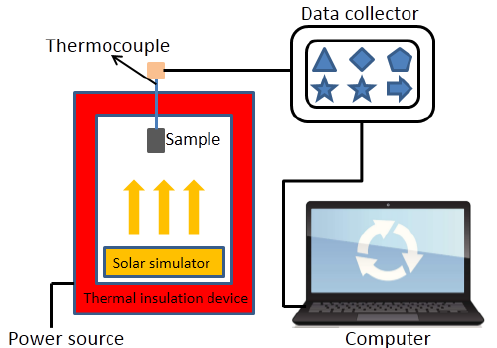
Figure 2. Time/temperature curve test device